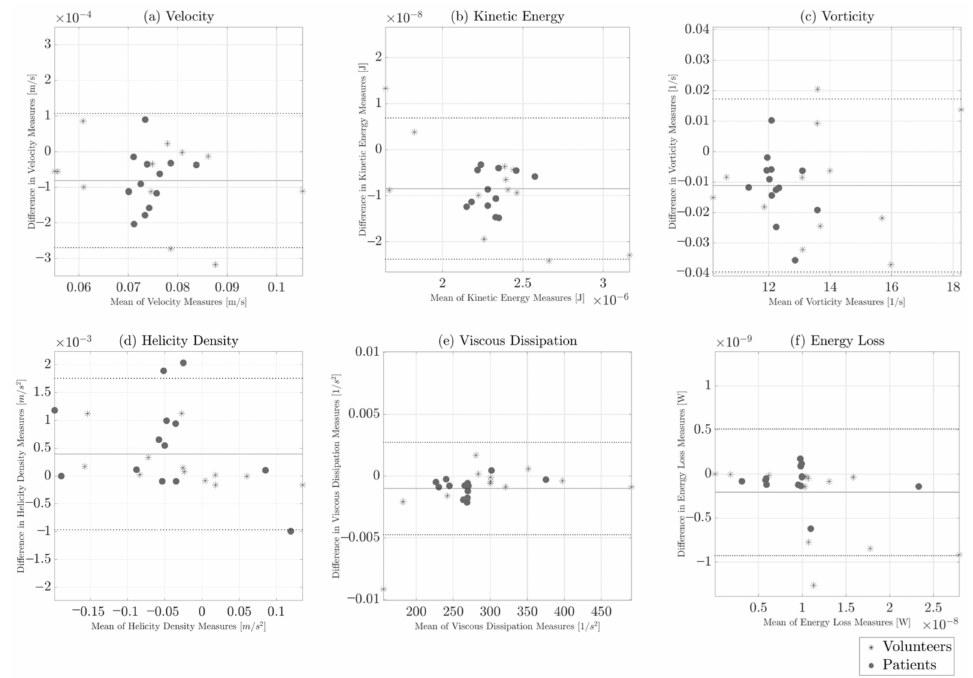
Figure A3. Bland-Altman plots represent the intra-observer reproducibility in the measurements of LV global hemodynamic parameters ( a – f ) at end-diastole. The thick line represents the mean difference, and the thin lines represent the limits agreement (1.96